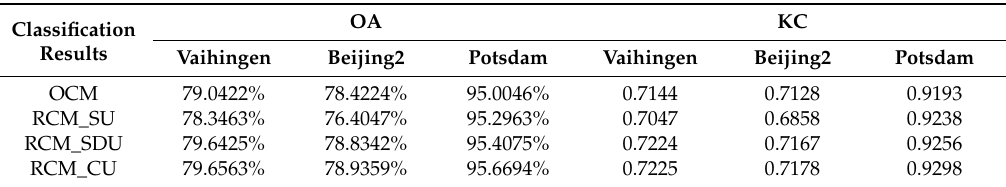
Table 3. Accuracy evaluation results: OCM represents the original classification map. RCM_SU, RCM_SDU, and RCM_CU represent the final reliable classification maps (RCMs) obtained by using SU, SDU, and CU for uncertainty control,